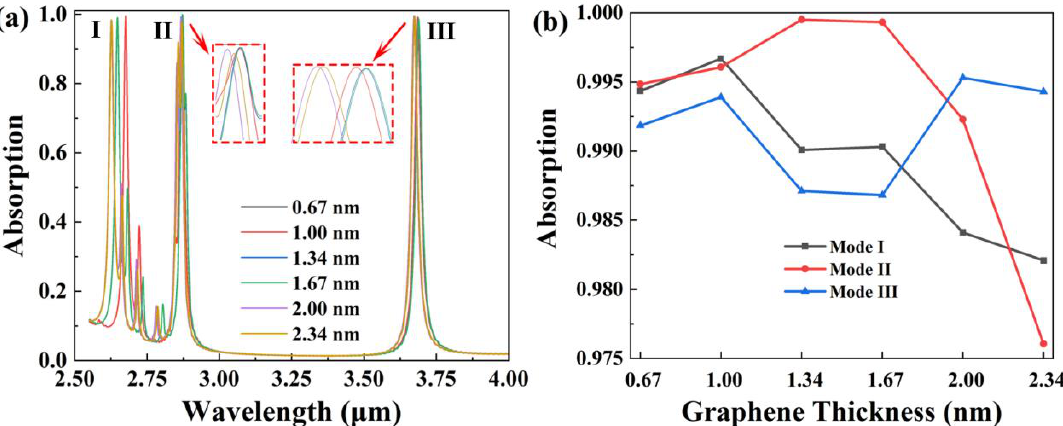
Figure 4. ( a ) An absorption efficiency diagram of the model with different graphene thickness. ( b ) The absorption efficiency when the scalloped graphene thickness is varied from 0.67 to 2.34 nm.